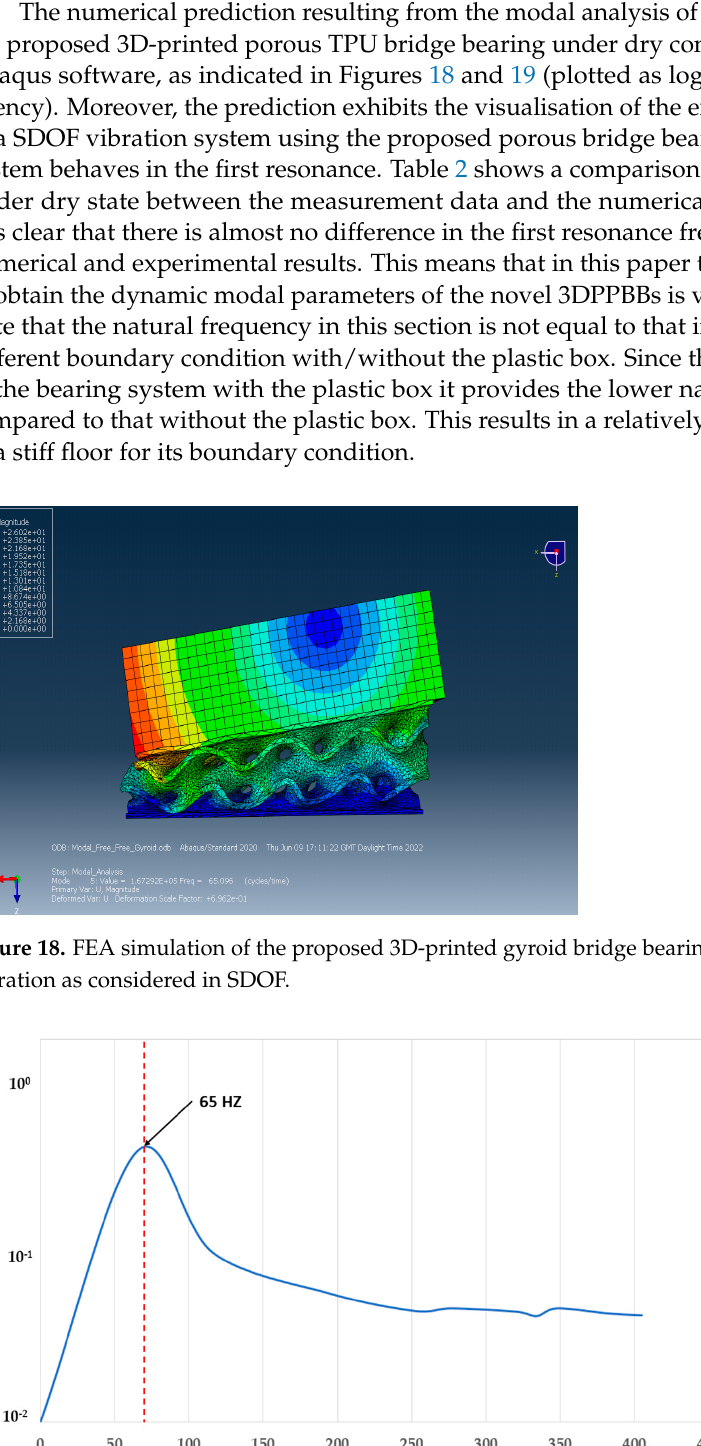
Figure 17. Finite element model setup of the modal analysis in Abaqus software.